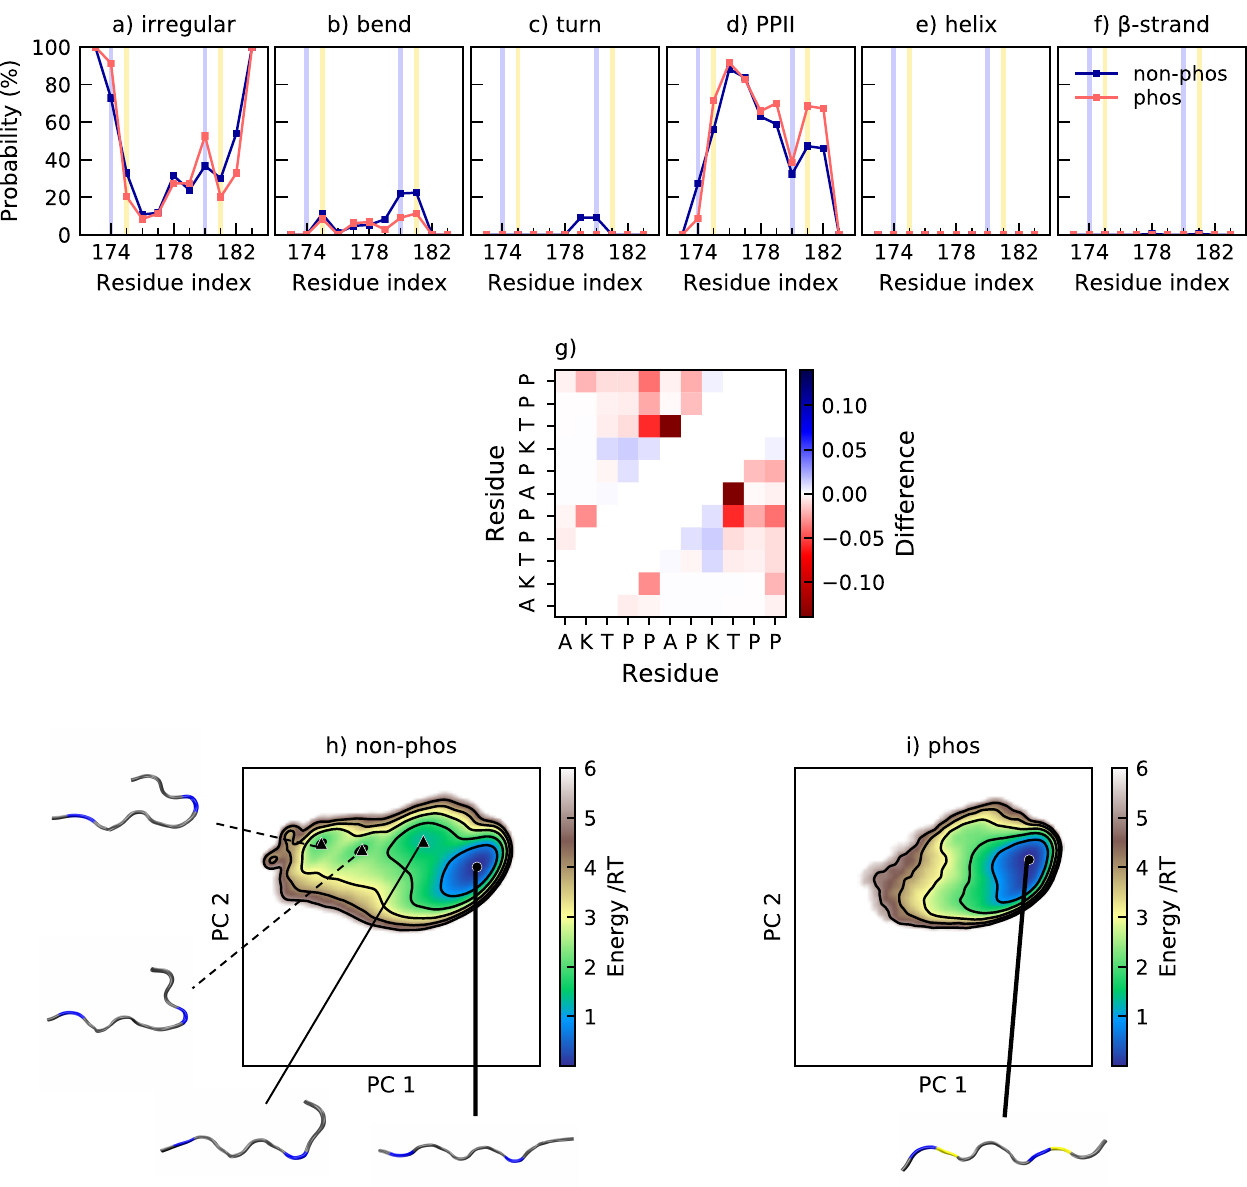
Figure 3. ( a – f ) Secondary structure content along the non-phosphorylated and phosphorylated sequence of Tau1. The helix includes α -helix and 3 10 -helix. β -strand also includes β -bridge. The positions of phosphorylated and positively charged residues are highlighted in yellow and blue, respectively; ( g ) change in contact probability upon phosphorylation of Tau1; ( h , i ) energy landscapes and conformations in minima of non-phosphorylated and phosphorylated Tau1. The energy landscapes are constructed using the first two components from principal component analysis, applying the same basis set for both variants. Hence, they are directly comparable. Contour lines are drawn for integer energy levels in the interval 1 ≤ RT ≤ 5 and the minimum of each basin is represented by a marker depending on the energy: (cid:108) : ≤ 1 RT , (cid:115) : ≤ 2 RT . A thick line corresponds to the most populated basin, while dashed lines to the least populated basins. In the conformations, positively charged residues are shown in blue, and phosphorylated residues in